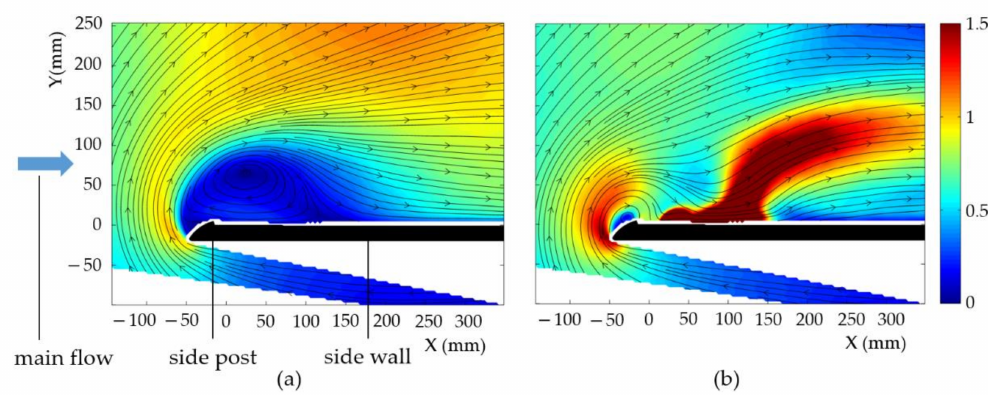
Figure 4. Flow separation at the side wall of the fume hood: ( a ) conventional fume hood with no active control and ( b ) investigated baseline fume hood with wall jets. Diagrams from PIV-Measurements: Sectional streamlines of the mean flow field in the measuring level and contours of the three-dimensional velocity magnitude normalized by the mean inflow